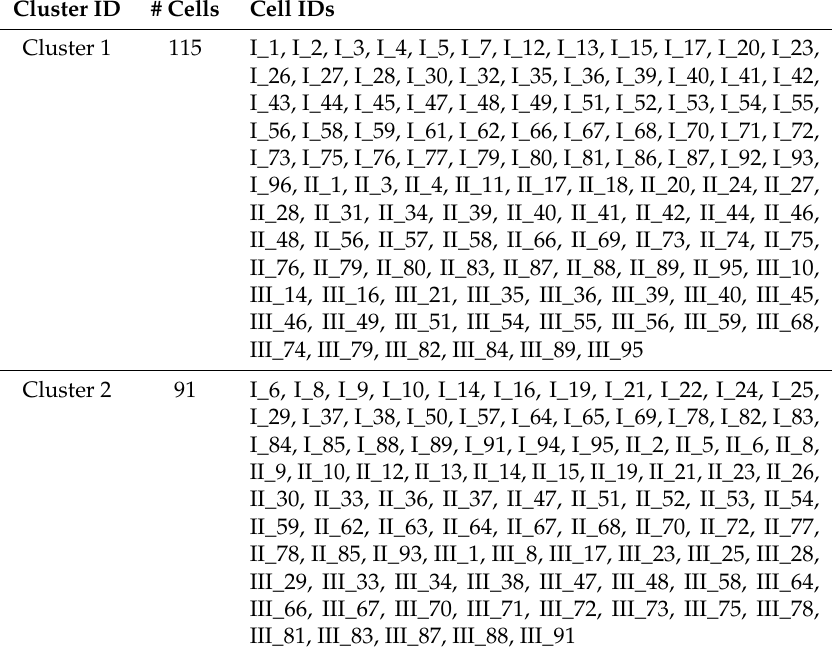
Table 3. Two resultant clusters and their participating cells after optimized fuzzy clustering ( cl = 2) from the scRNA-seq gene expression